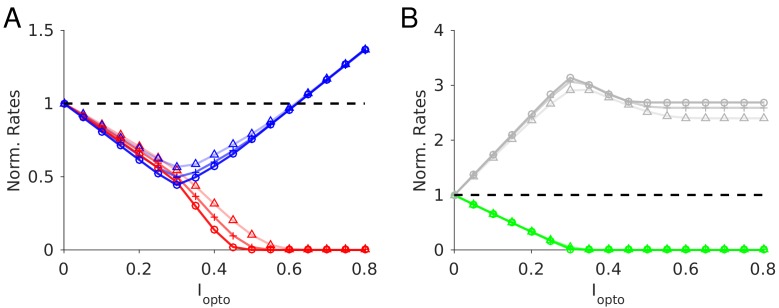
Model 2.Robustness with respect to change in the average connectivity, K. Triangles: K = 500; cross: K = 1000; circles: K = 2000. Nα = 10000 neurons per population. Color code and parameters as in Figure 10. Baseline firing rates: K = 500: rE = 4.2 Hz rI = 7.0 Hz, rS = 7.0 Hz, rX = 4.0 Hz, K = 1000: rE = 4.0 Hz, rI = 6.8 Hz, rS = 6.8 Hz, rX = 3.8 Hz; K = 2000: rE = 3.7 Hz, rI = 6.8 Hz, rS = 6.7 Hz, rX = 3.8. Rates are averaged over 10s.